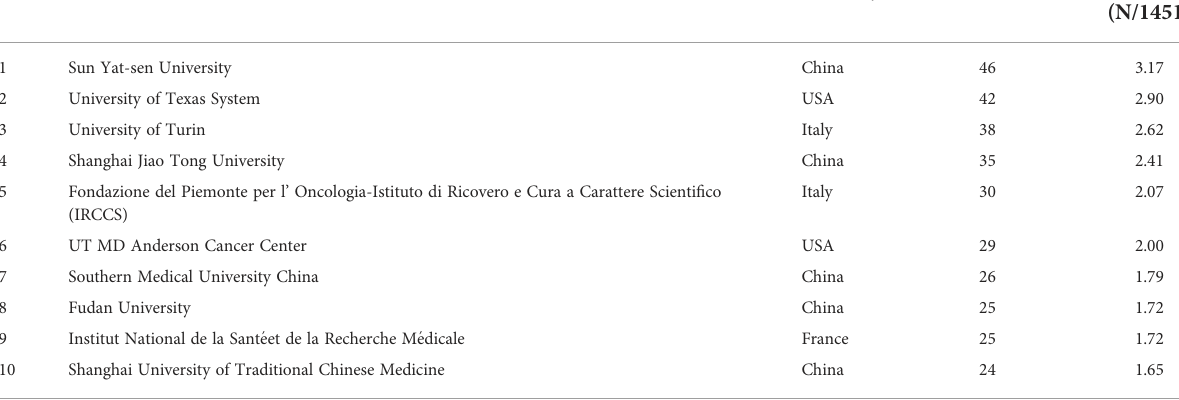
TABLE 1 Top 10 institutions published studies related to drug resistance in colorectal cancer.